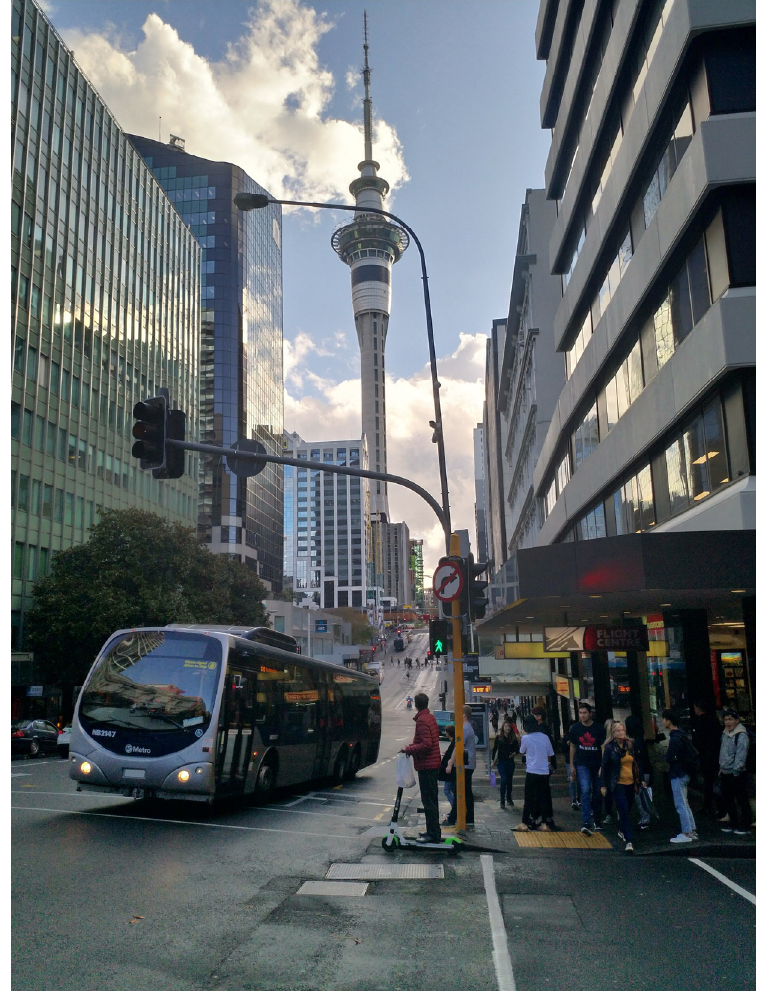
Figure 18. Example of conditions in other geographical areas.